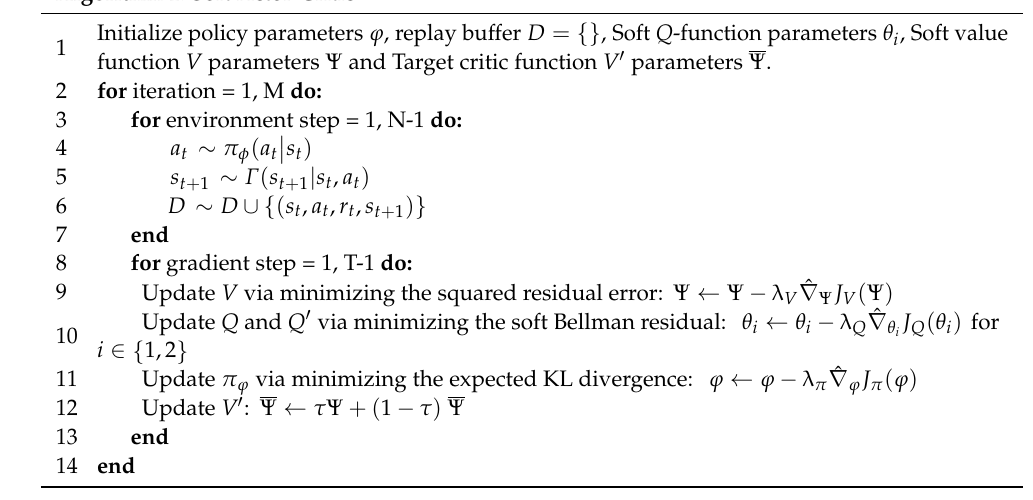
Table 2. Algorithm and model